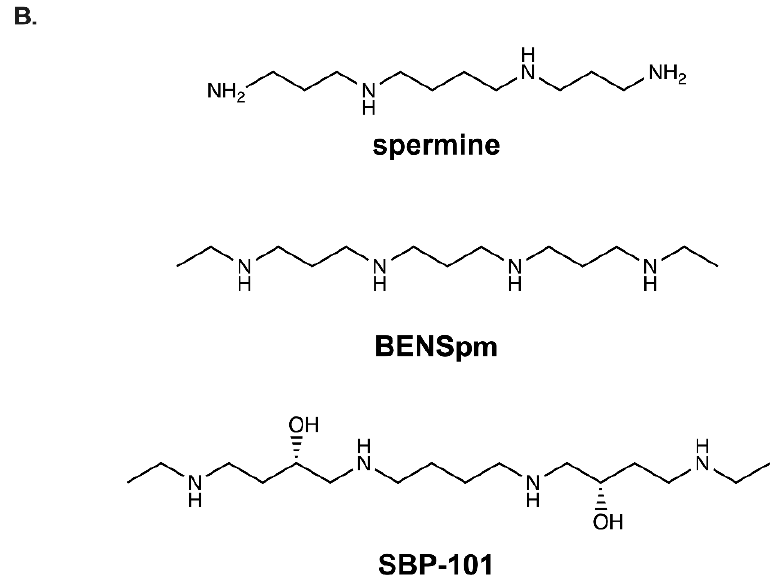
Figure 1. Polyamine metabolism is regulated through coordinated biosynthesis, catabolism, and transport. Ornithine decarboxylase (ODC) is a rate-limiting enzyme in polyamine biosynthesis ( A ). It catalyzes the formation of putrescine from L-ornithine. Spermidine synthase (SPDS) catalyzes the formation of spermidine from putrescine, and spermine synthase (SMS) assists in producing spermine from spermidine. Both reactions require decarboxylated adenosylmethionine produced by S-adenosylmethionine decarboxylase (AdoMetDC), the second rate-limiting enzyme in polyamine biosynthesis. Spermine oxidase (SMOX) directly catabolizes spermine to spermidine and produces the toxic byproducts, 3-aminopropanal and hydrogen peroxide. Alternatively, spermine can be acetylated by spermidine/spermine N 1 -acetltransferase (SSAT) to form N 1 -acetyl-spermine, which can be exported from the cell or further oxidized by polyamine oxidase (PAOX) to form spermidine. Spermidine can be catabolized to putrescine in a similar manner, forming N 1 -acetyl-spermidine as an intermediary. Analogues of the polyamine spermine compete for uptake into cells, and their accumulation influences polyamine metabolism ( B ). The well-characterized polyamine analogue, N 1 , N 11 -bisethylnorspermine, influences ODC, AdoMetDC, SSAT, and SMOX to affect polyamine metabolism. The effects of the spermine analogue, SBP-101, on polyamine metabolism are addressed in this